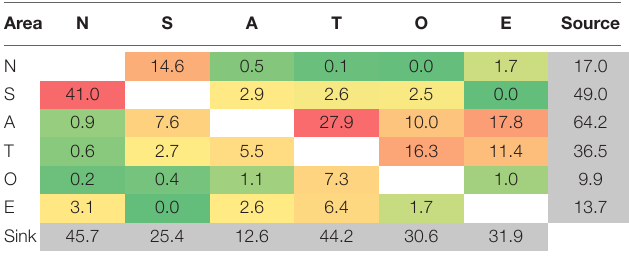
Dispersals from an area (source) in rows to an area (sink) in columns. A, Africa; E, temperate Eurasia; N, North America; O, Oceania incl. Australasia; S, South America; T, tropical Asia. Note that the approximate rate of dispersals per million year is the sum of events divided by the crown age of the